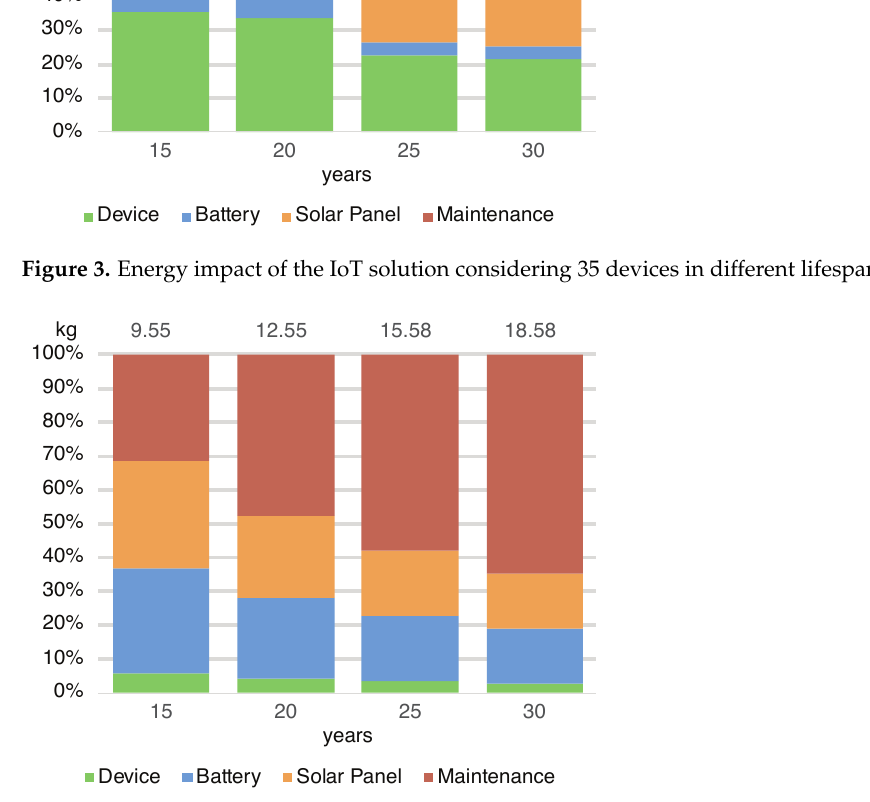
Figure 4. Waste produced by IoT solution considering 35 devices in different lifespan